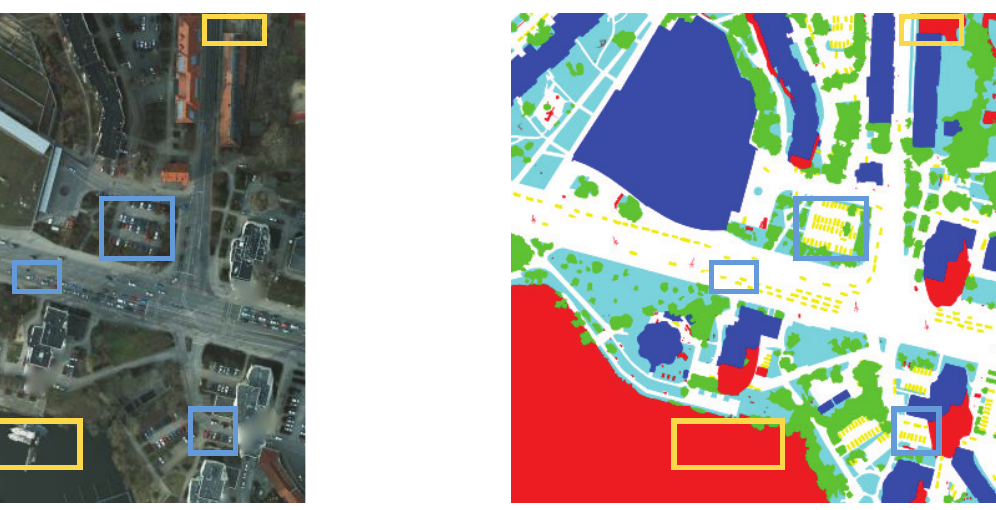
Figure 1. Illustration of Potsdam dataset. The left image is a raw image in Potsdam dataset, and the right image is the corresponding label. Blue boxes mark the tiny objects such as cars, and yellow boxes mark complicated objects such as clutters.